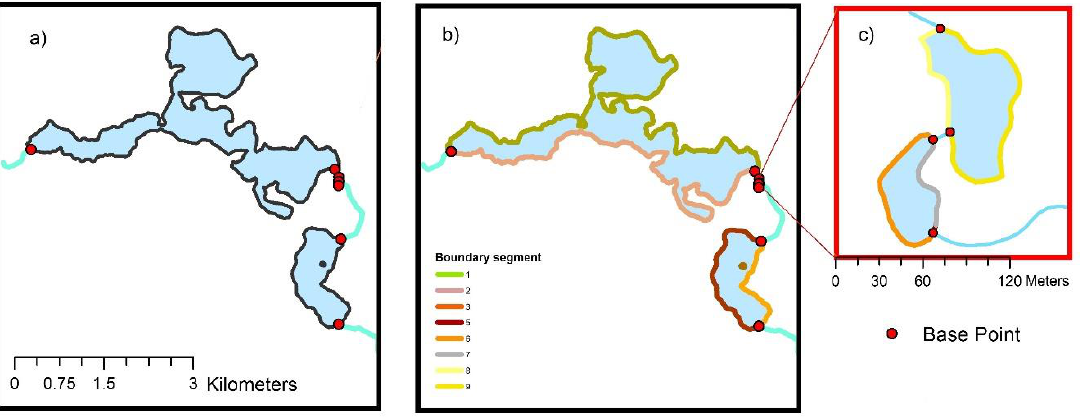
Figure 16. Source data for generating the first skeleton based on 8 base points and 9 segments of polygon (lake) boundaries: ( a ) lakes with the location of base points; ( b ) segmentation of the boundary lines of lakes; ( c ) two small lakes with segments of their boundary lines.